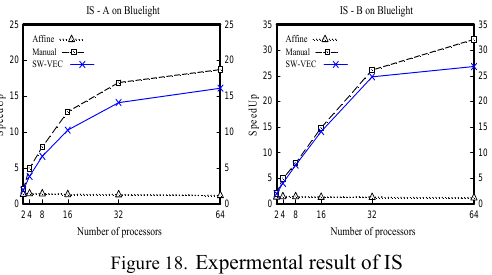
Figure 18. Expermental result of